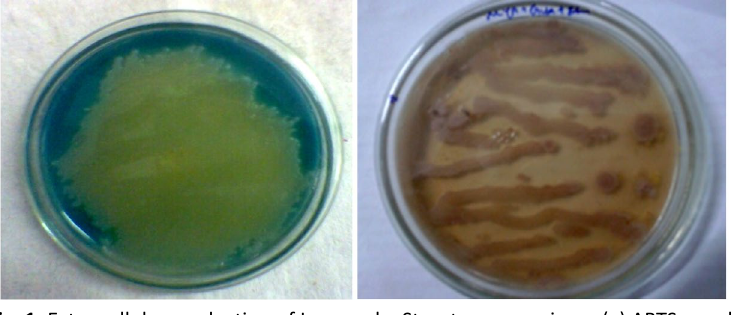
Fig. 1. Extra cellular production of Laccase by Streptomyces syiceus (a) ABTS as substrate (b) Guiacol as